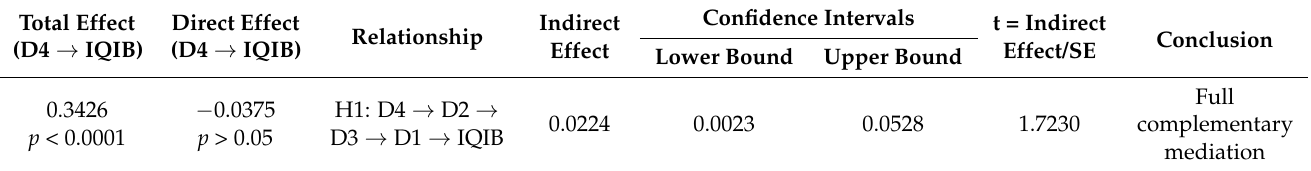
Table 3. Sequential mediation